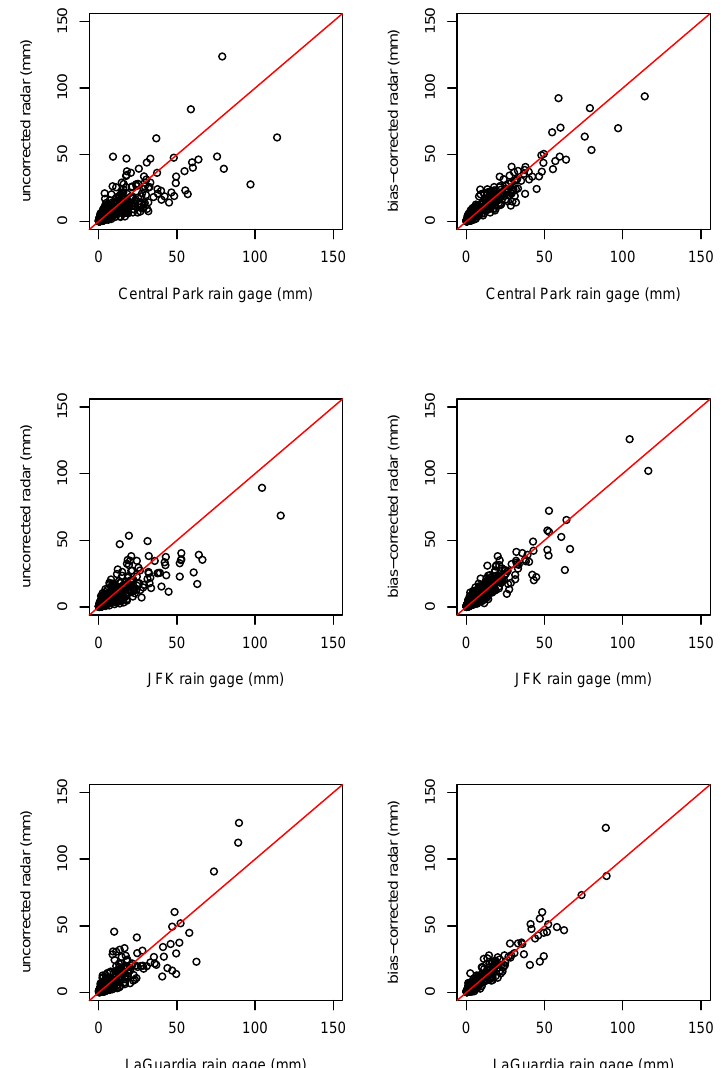
Figure 4. Comparison of daily rain gage rain depths and radar rainfall rain depths for un-bias corrected ( left column ) and bias-corrected ( right column ) data. The top panel represents observations over 15 years of warm seasons from the Central Park rain gage, the middle panel represents observations from the JFK rain gage, and the bottom panel represents observations from the LaGuardia rain gage. The red line represents a 1 to 1